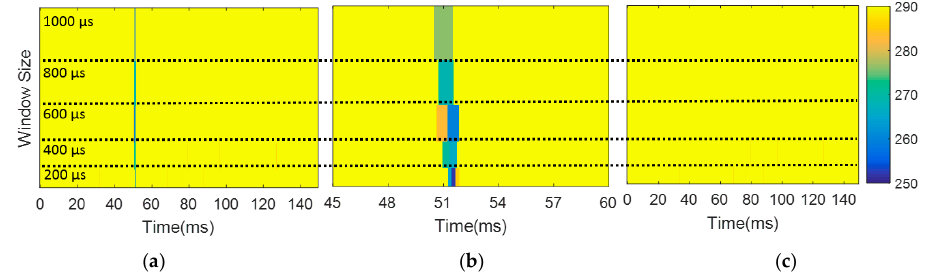
Figure 12. The spectra of frequency centroid (unit: kHz), ( a ) embedded streamed signals ( SNR = 1.0), ( b ) zoomed embedded stream signals, and ( c ) original streamed signals.